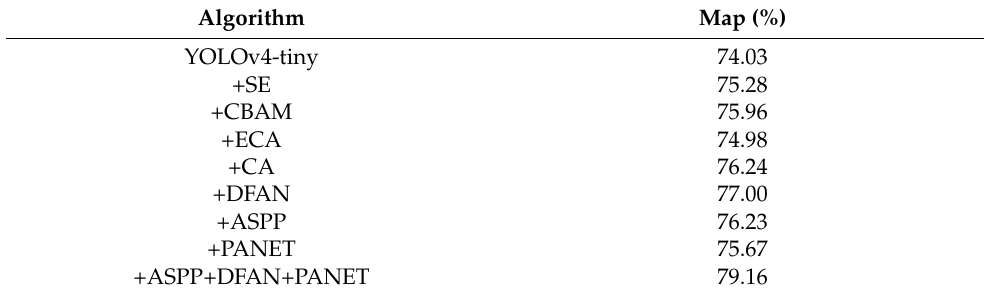
Table 2. Ablation experiments.